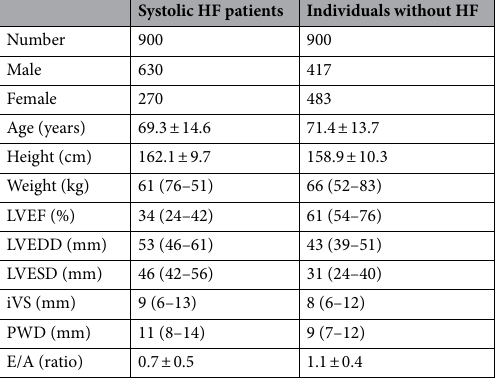
Table 1. Information on individuals with and without systolic